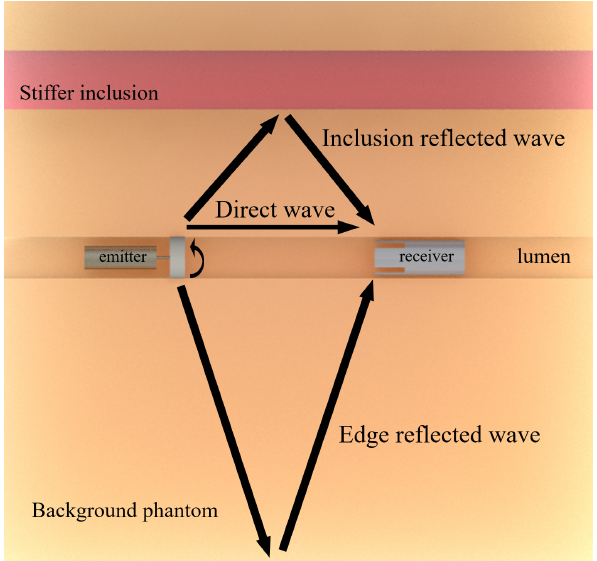
Figure 5. Scheme that depicts the three expected propagation paths for the transluminal T–R tests: direct wave, reflected wave against the inclusion, and the reflected wave against the outer surface of the phantom.